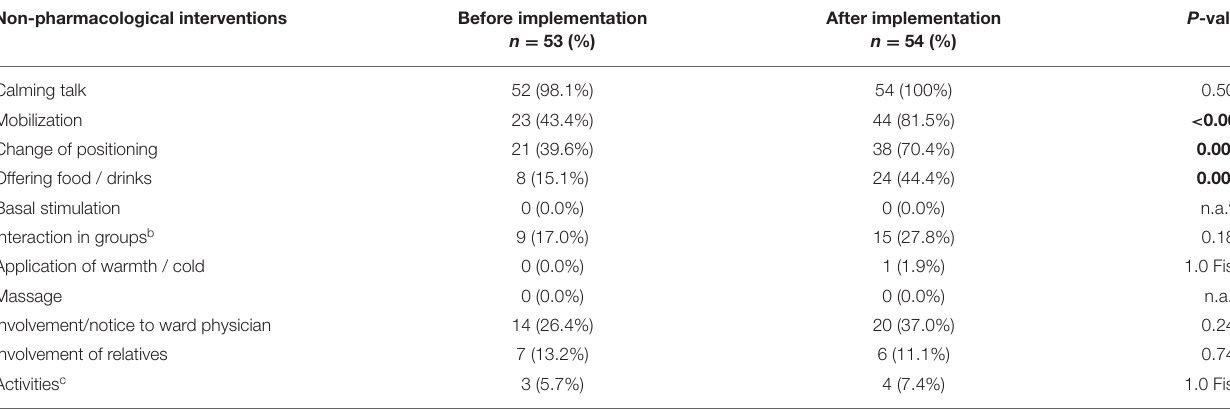
TABLE 3 | Non-pharmacological interventions before and after STI implementation. Non-pharmacological interventions